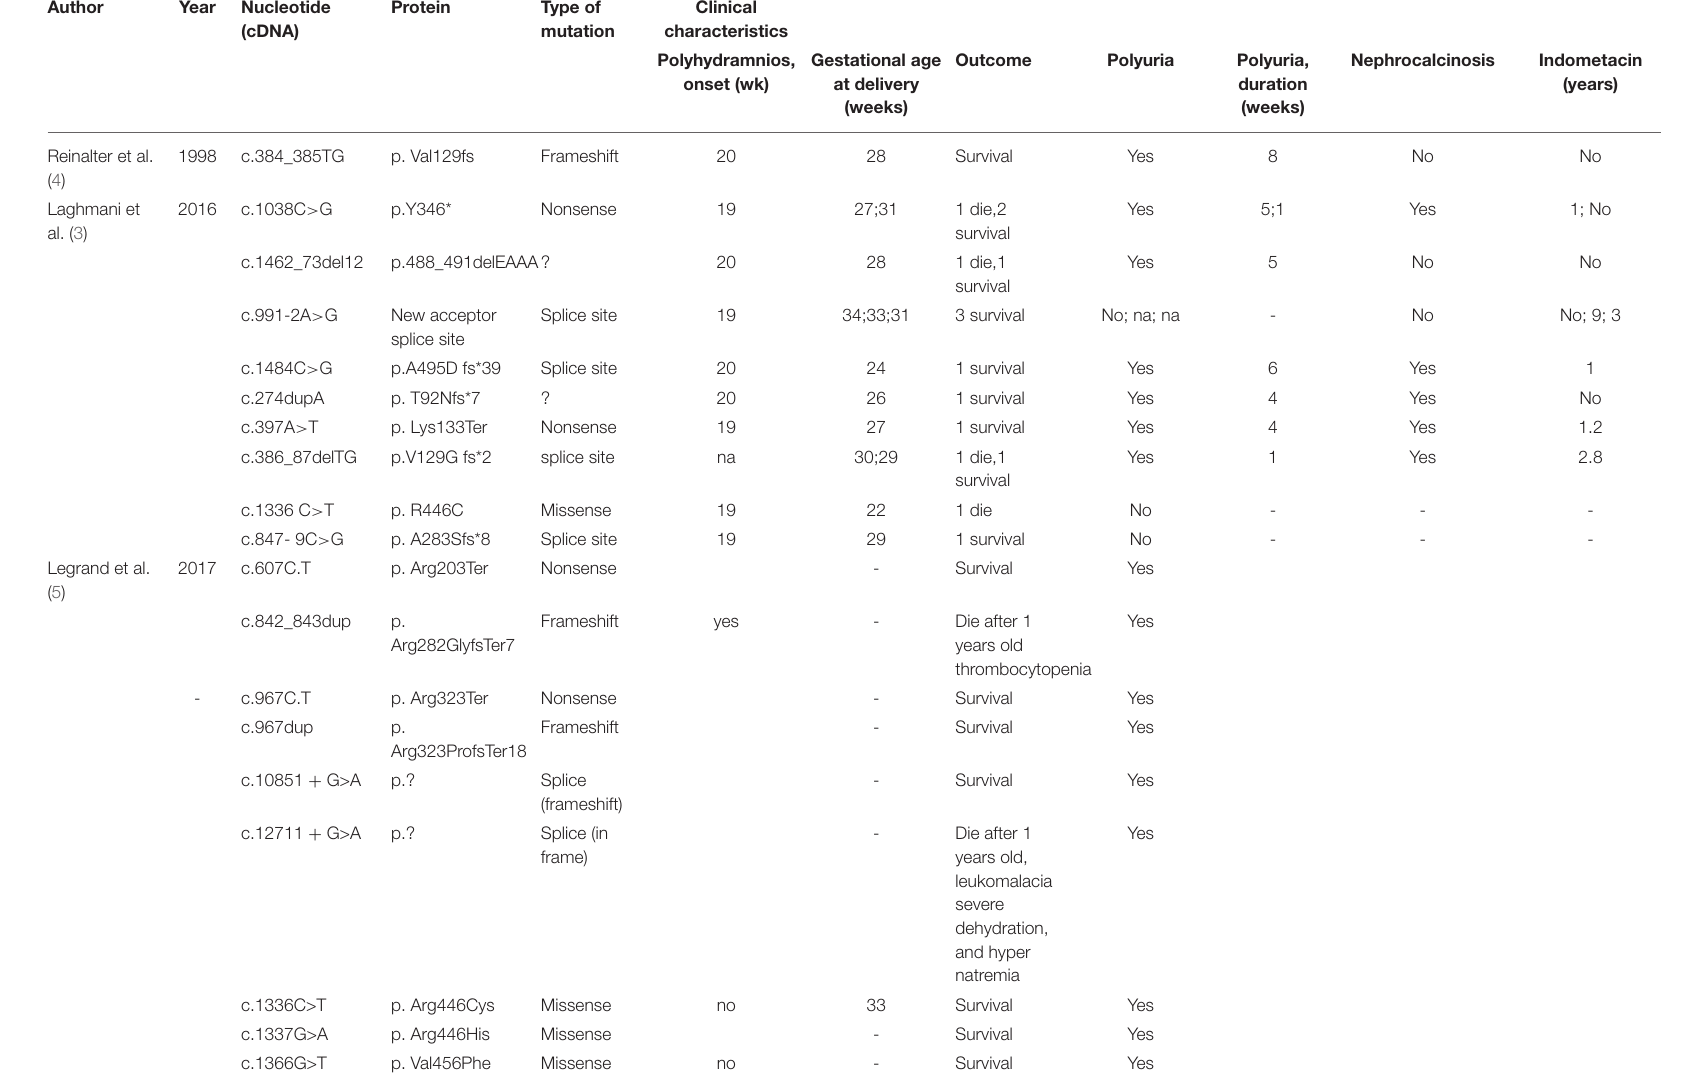
TABLE 2 | Genotype and clinical features of each MAGED2 mutations. Author